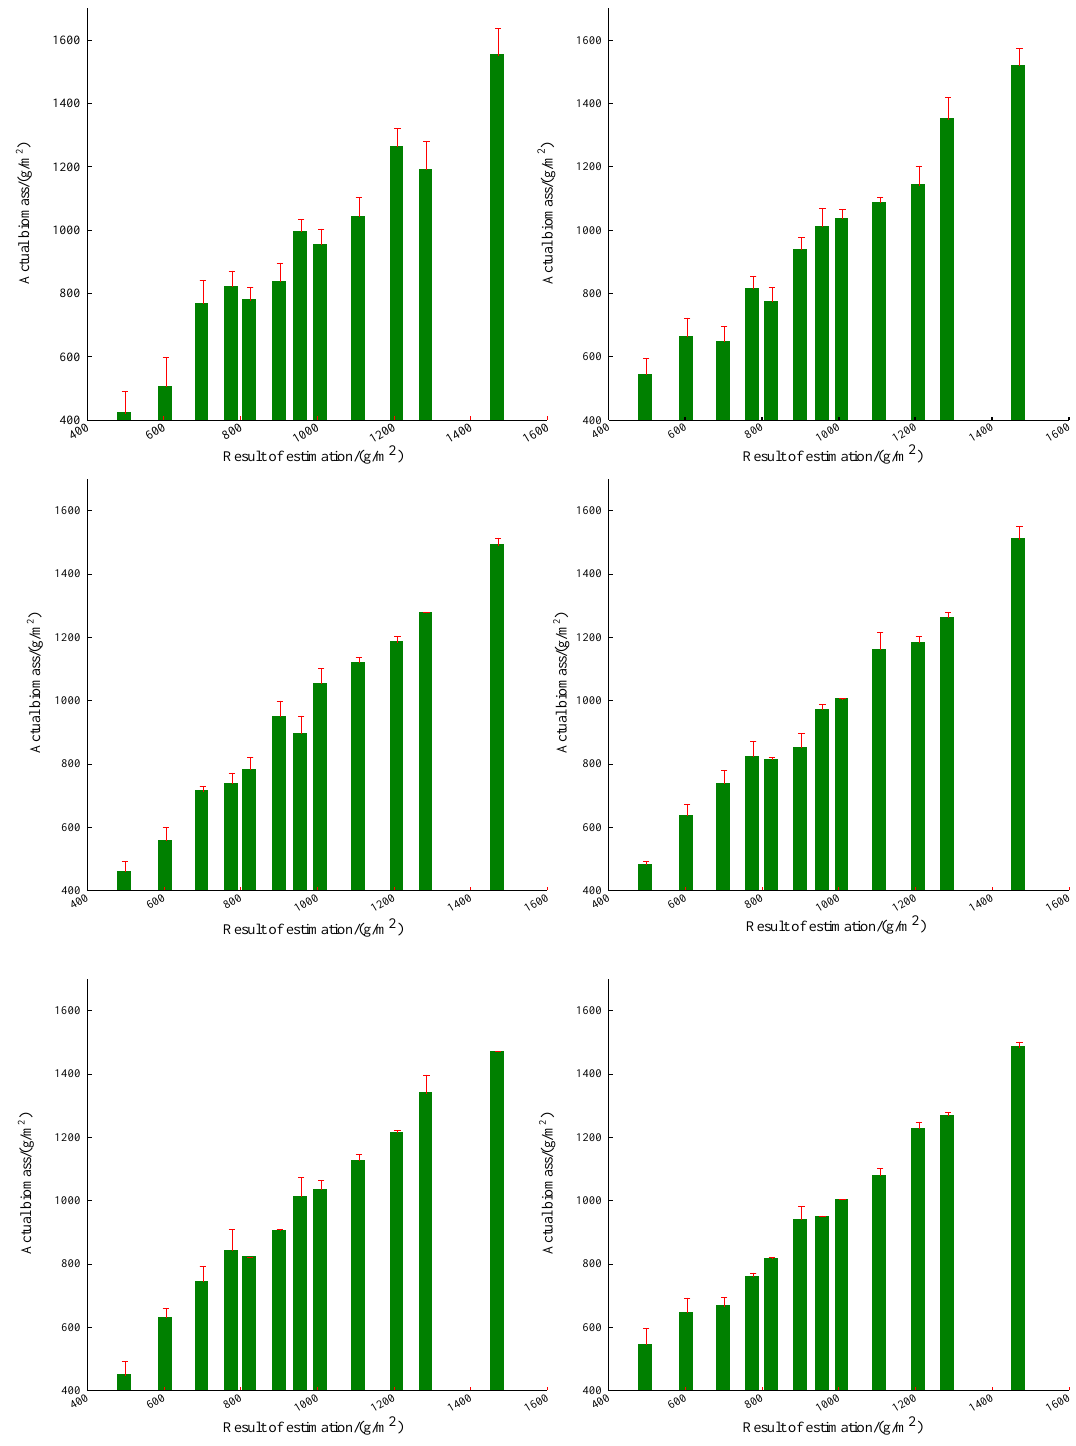
Figure 8. Comparison between predicted and actual leaf